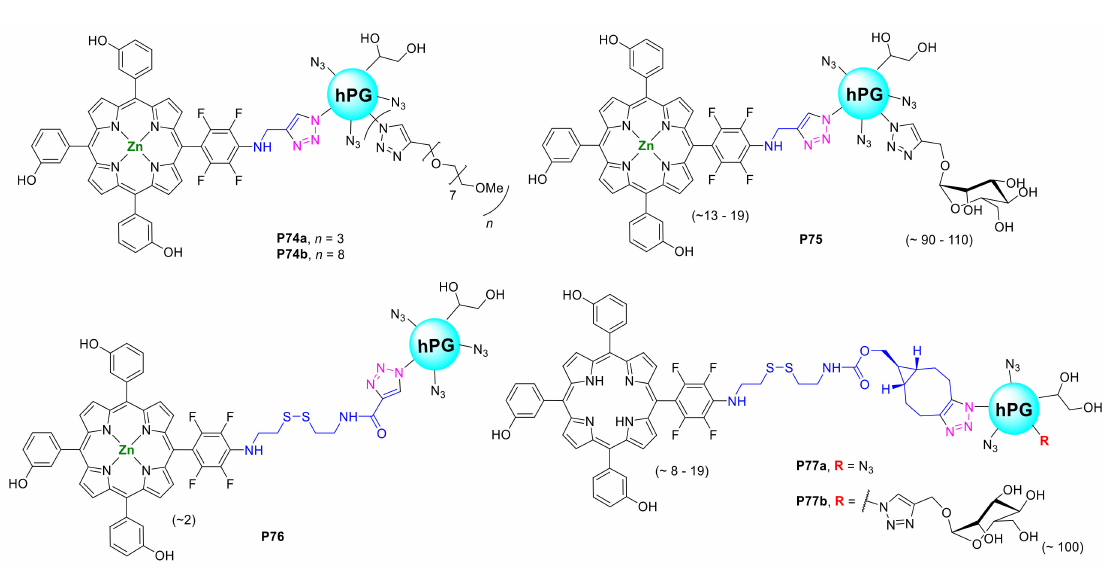
Figure 9. Structure of porphyrin-hPG-PEG conjugates P74a , b , P75 , P76 and P77 . Numbers in brackets give the approximate loading per polymer with porphyrin molecules and mannose groups,